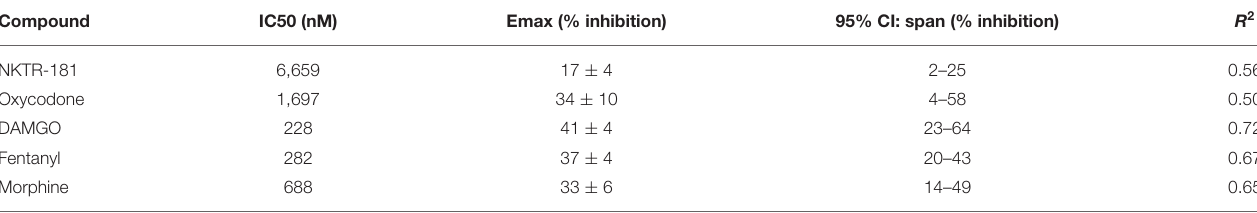
TABLE 1 | The dose-response curve of voltage-activated calcium channel currents (VACC) inhibition by NKTR-181 and other known Mu opioid receptor (MOPr) agonists.